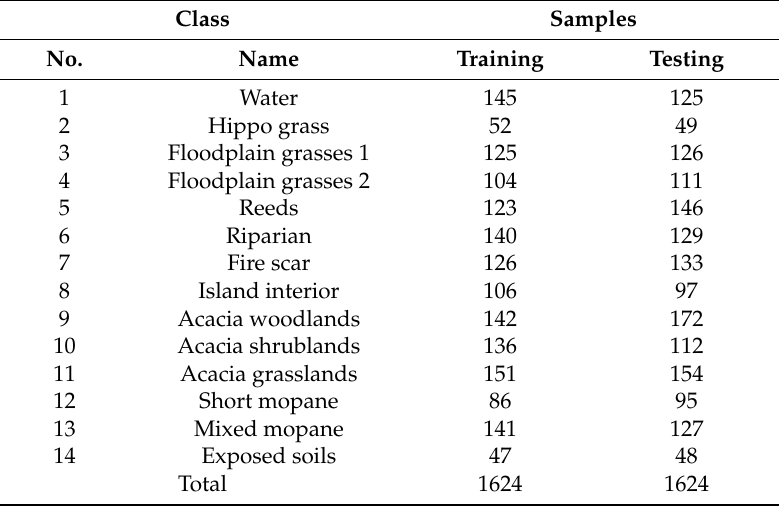
Table 2. Color coding and sample size for Botswana scene.